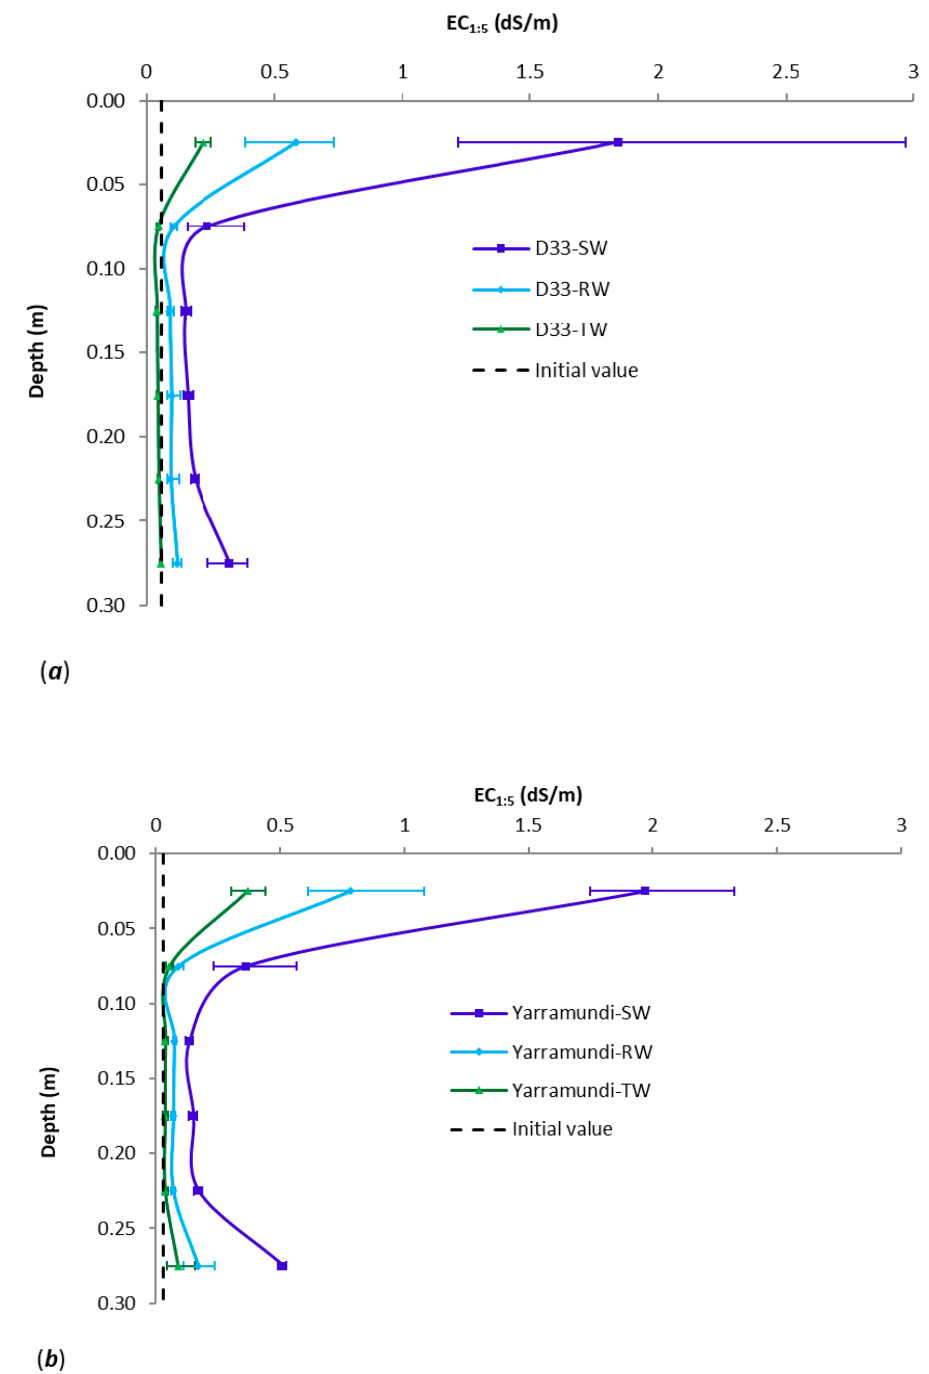
Figure 5. Salinity profile in terms of EC 1:5 using TW, RW, and SW as irrigation water in ( a ) D33 paddock soil columns and ( b ) Yarramundi paddock soil columns after the study period of 330 days. The dotted line shows the initial EC 1:5 ; the error bars show the minimum and maximum value of EC 1:5 in columns irrigated with specific irrigation water.